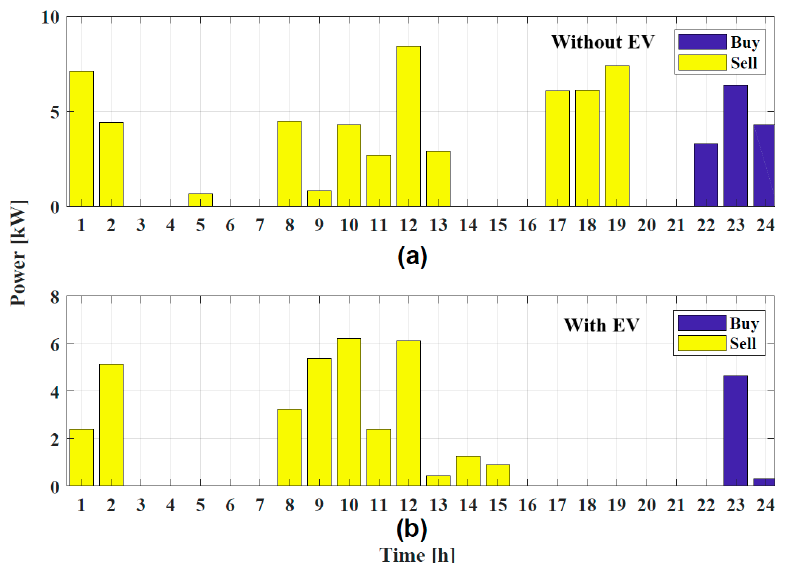
Figure 7. Power bought/sold to/from the grid in the 24-h time intervals with and without the presence of EV. ( a ) is representing the Grid status without presence of EV in H-MG while ( b ) is with presence of